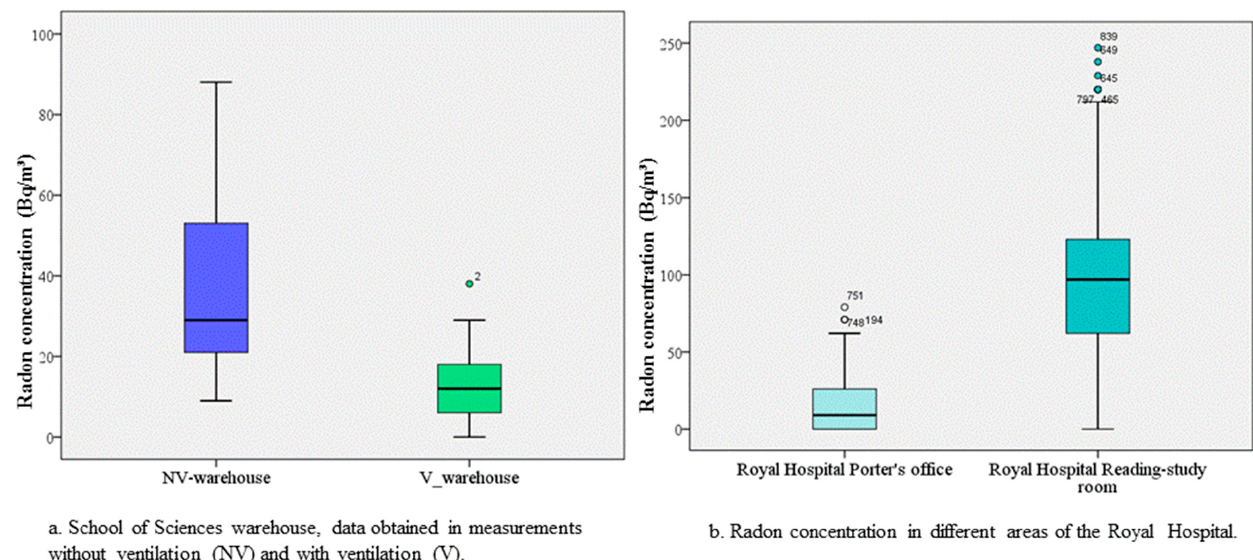
Figure 3. ( a ) and ( b ) Comparison of radon concentrations as a function of the presence or the absence of ventilation.